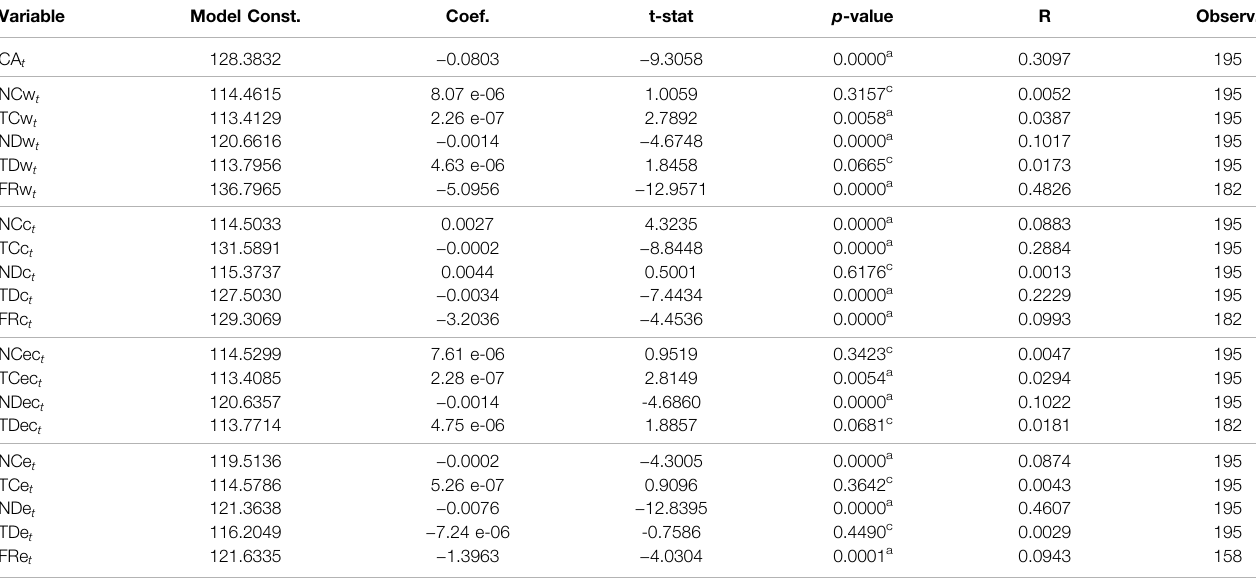
TABLE 7 | Bivariate regression models for COVID-19 effect on S&P Europe 350 ESG Index. Variable Model Const.